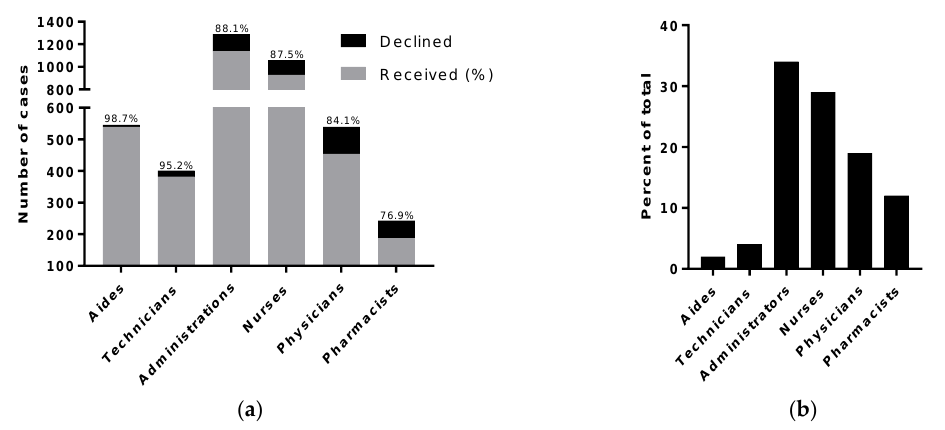
Figure 2. Influenza vaccination by occupation in PHCC. ( a ) Percent of PHCC respondents vaccinated by job category; ( b ) Distribution of unvaccinated staff among different occupations. Table 2. Vaccination compliance in association with participants’ occupation.